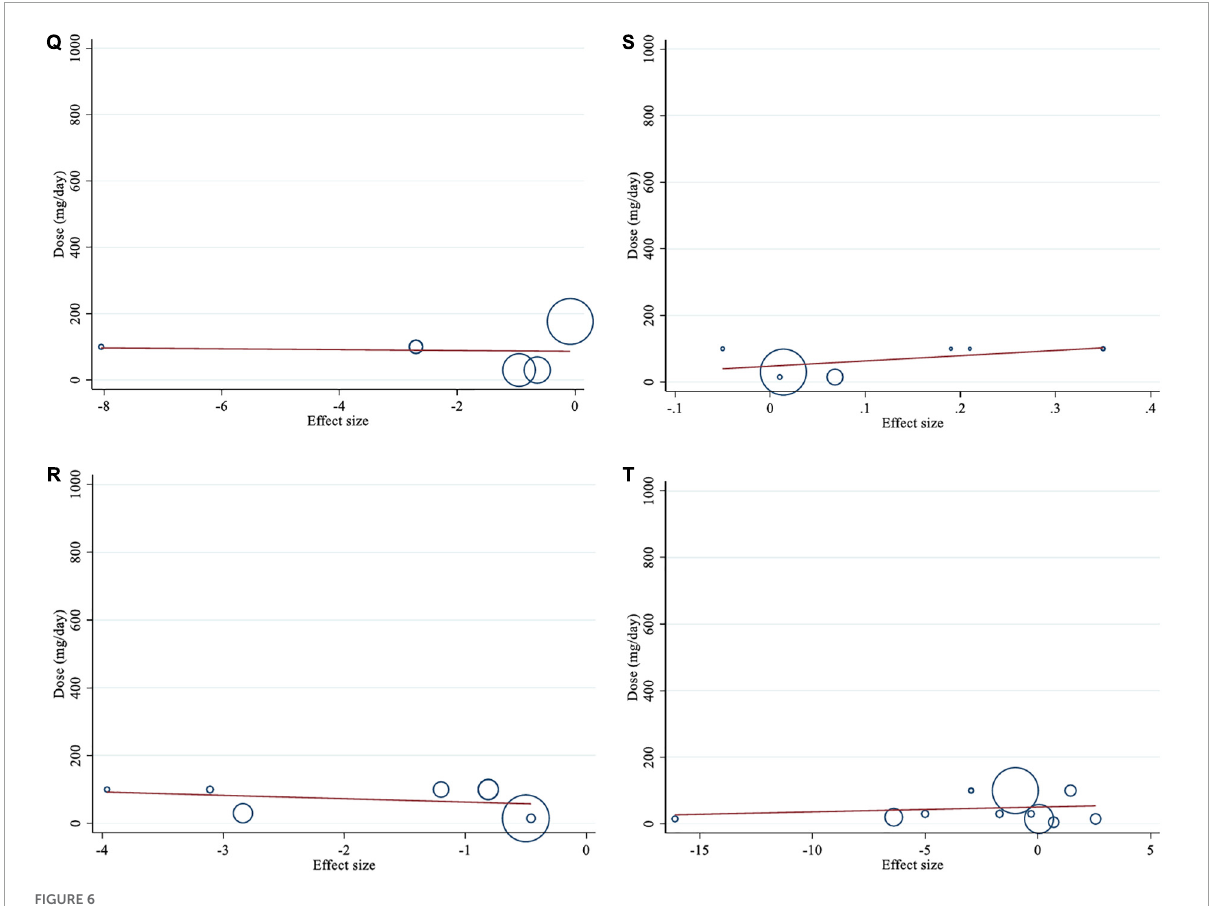
P Begg = 0.348; Figure 3J ), IL-6 (P Egger = 0.108, P Begg = 1.00; Figure 3L ), TNF- α ( P Egger = 0.130, P Begg = 1.00; Figure 3M ), weight ( P Egger = 0.183, P Begg = 0.702; Figure 3N ), BMI (P Egger = 0.382, P Begg = 0.542; Figure 3O ), WC ( P Egger = 0.238, P Begg = 0.216; Figure 3P ), MDA ( P Egger = 0.105, P Begg = 0.138; Figure 3R ), TAC ( P Egger = 0.050, P Begg = 0.621; Figure 3S ), ALT ( P Egger = 0.403, P Begg = 0.131; Figure 3T ), and AST ( P Egger = 0.829, P Begg = 784; Figure 3U ) levels, using Begg’s test and Egger’s tests. But among articles evaluating the impact of saffron on insulin ( P Egger = 0.041, P Begg = 0.072; Figure 3F ), SBP ( P Egger = 0.042, P Begg = 1.00; Figure 3I ), CRP (P Egger = 0.023, P Begg = 0.697; Figure 3K ) FM% ( P Egger = 0.001, P Begg = 0.060; Figure 3Q ), and ALP ( P Egger = 0.004, P Begg = 0.462; Figure 3V